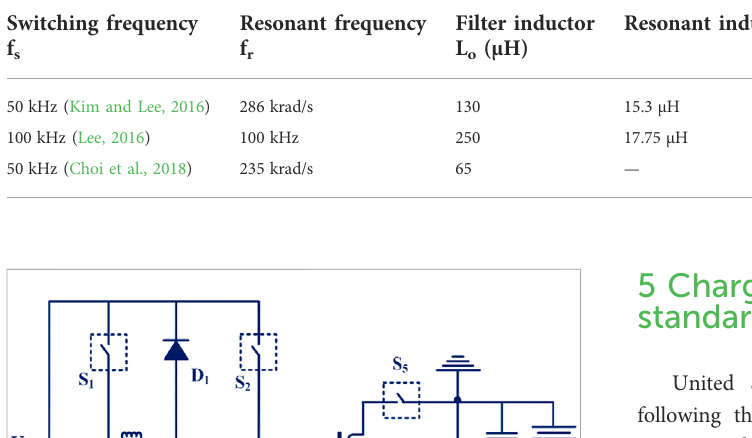
TABLE 6 Hybrid converter frequency range summary.